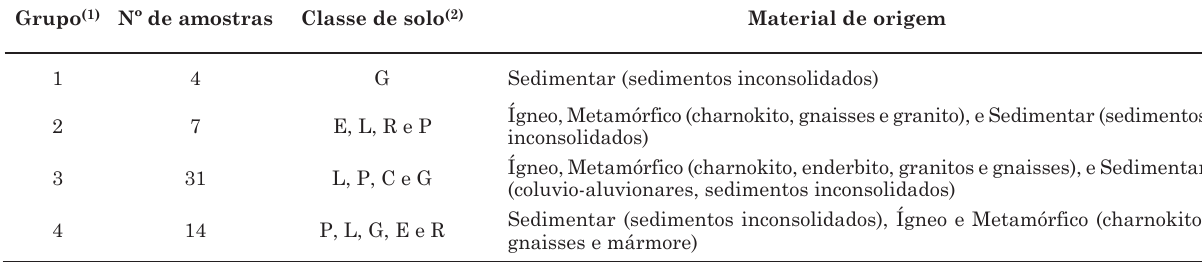
Quadro 5. classes taxonômicas e materiais de origem dos solos nos diferentes